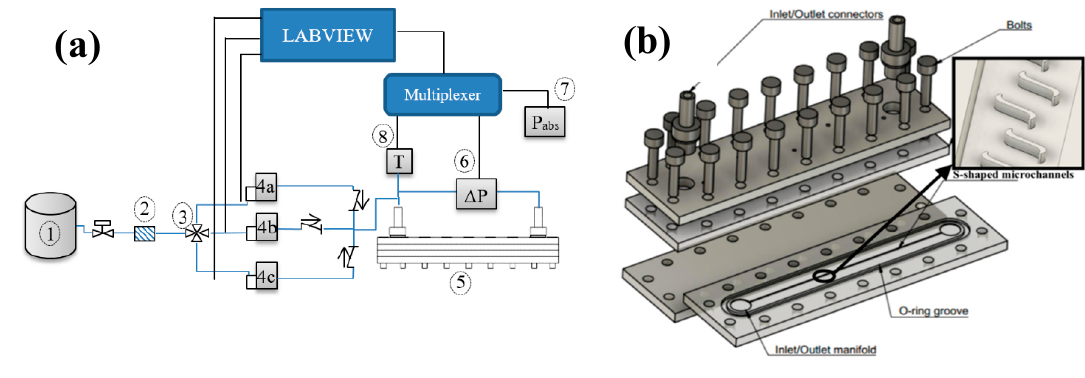
Figure 8. Experimental test bench ( a ) and microchannel assembly ( b ).